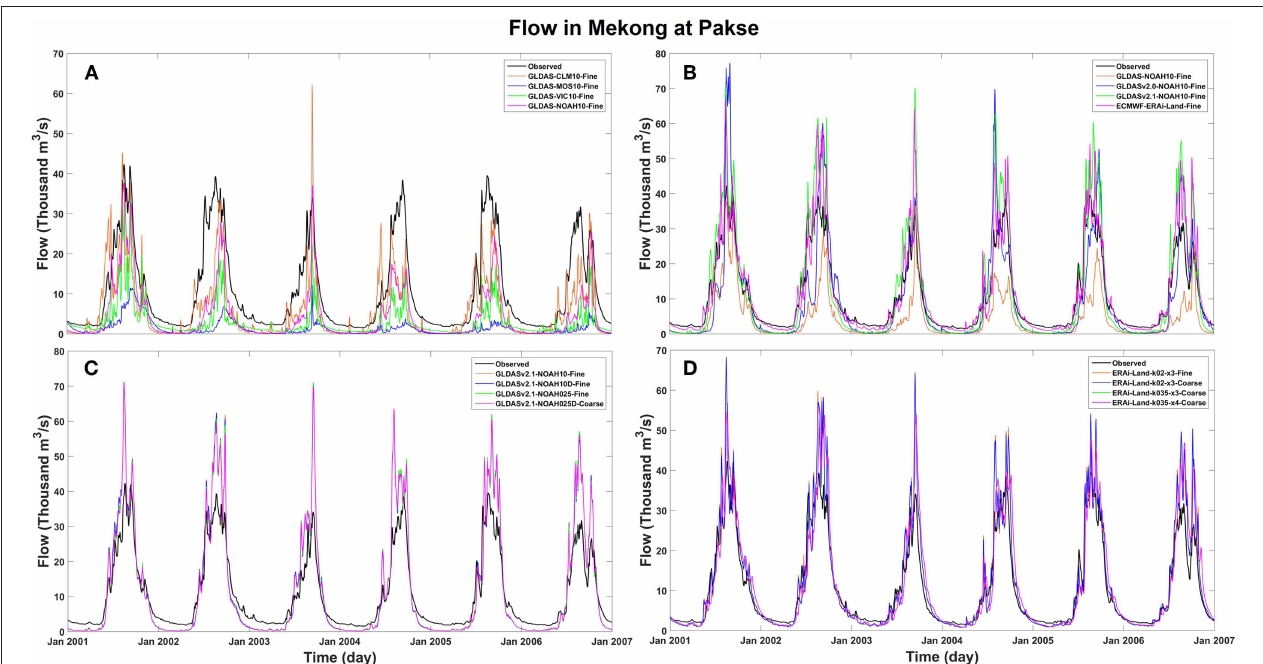
FIGURE 4 | Example of the simulated daily flow hydrograph in the Mekong basin as a function of different (A) LSM, (B) input forcing, (C) spatio-temporal resolution of LSM and routing model, and (D) routing model parameter. Observed river flow is shown in black line.